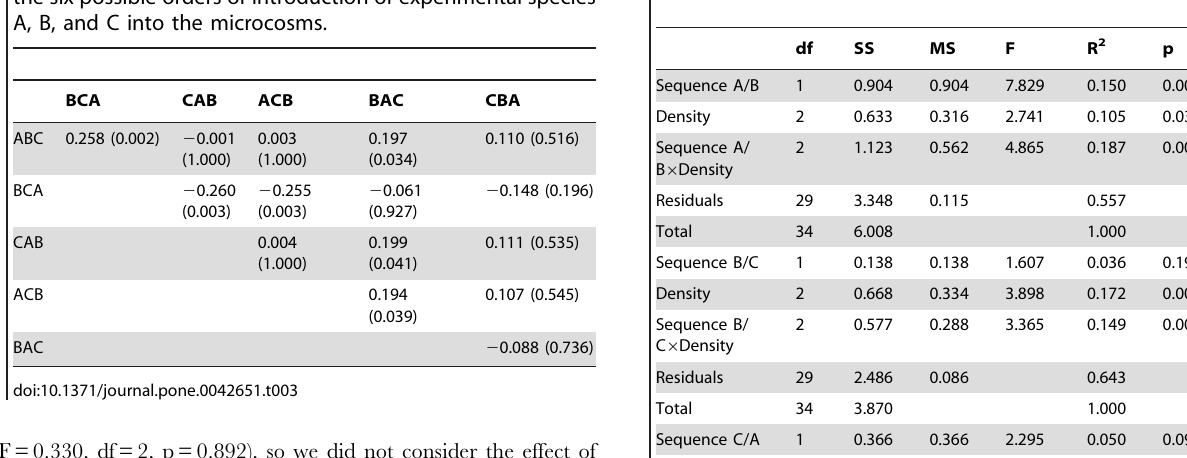
Table 5. Pairwise a posteriori tests for (a) first arrival 6 density and (b) late arrival 6 density by PERMANOVA with Bray-Curtis distances in the protozoan community states.